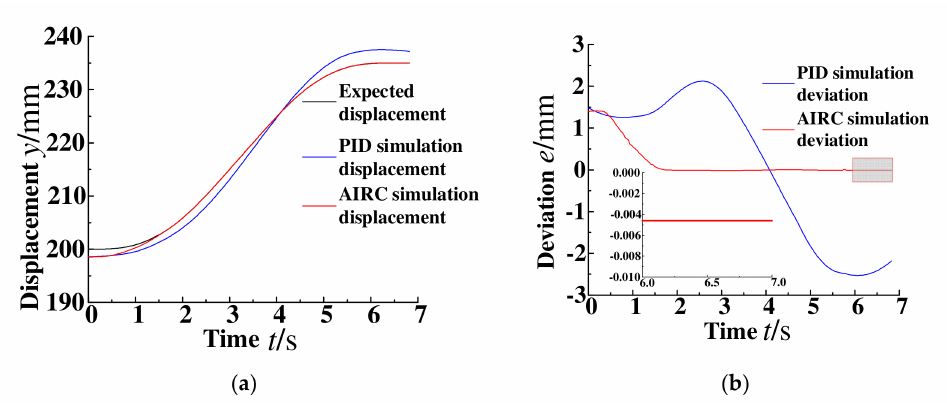
Figure 8. System displacement and deviation curve under working condition 3 (cid:13) . ( a ) System displace- ment curve. ( b ) System displacement deviation